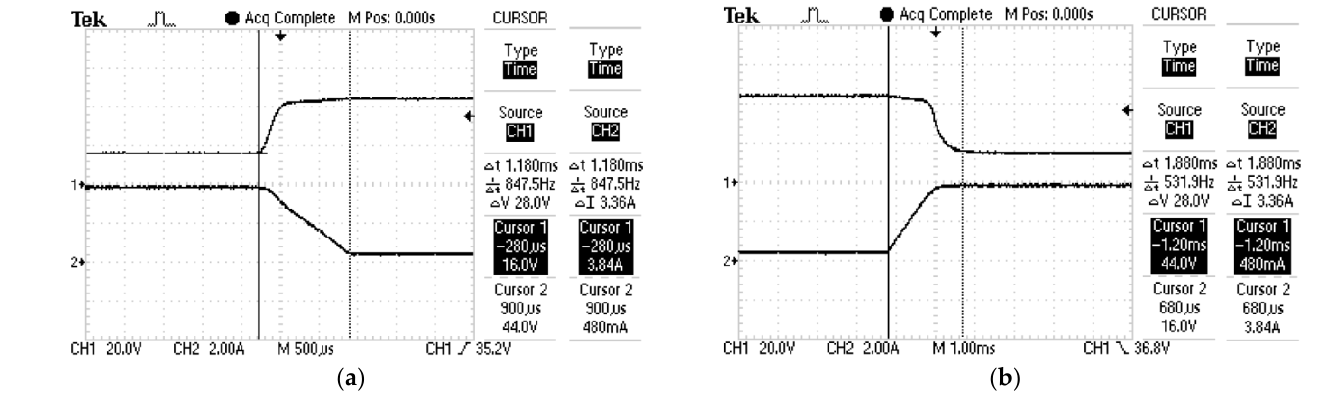
Figure 16. Responses of the PVE output to Ro steps under operating conditions 4 A/45 V: ( a ) The output response for the increase step change of resistances from 4.2 Ω to 92 Ω ; ( b ) The output response for the decrease step change of resistances from 92 Ω to 4.2 Ω .